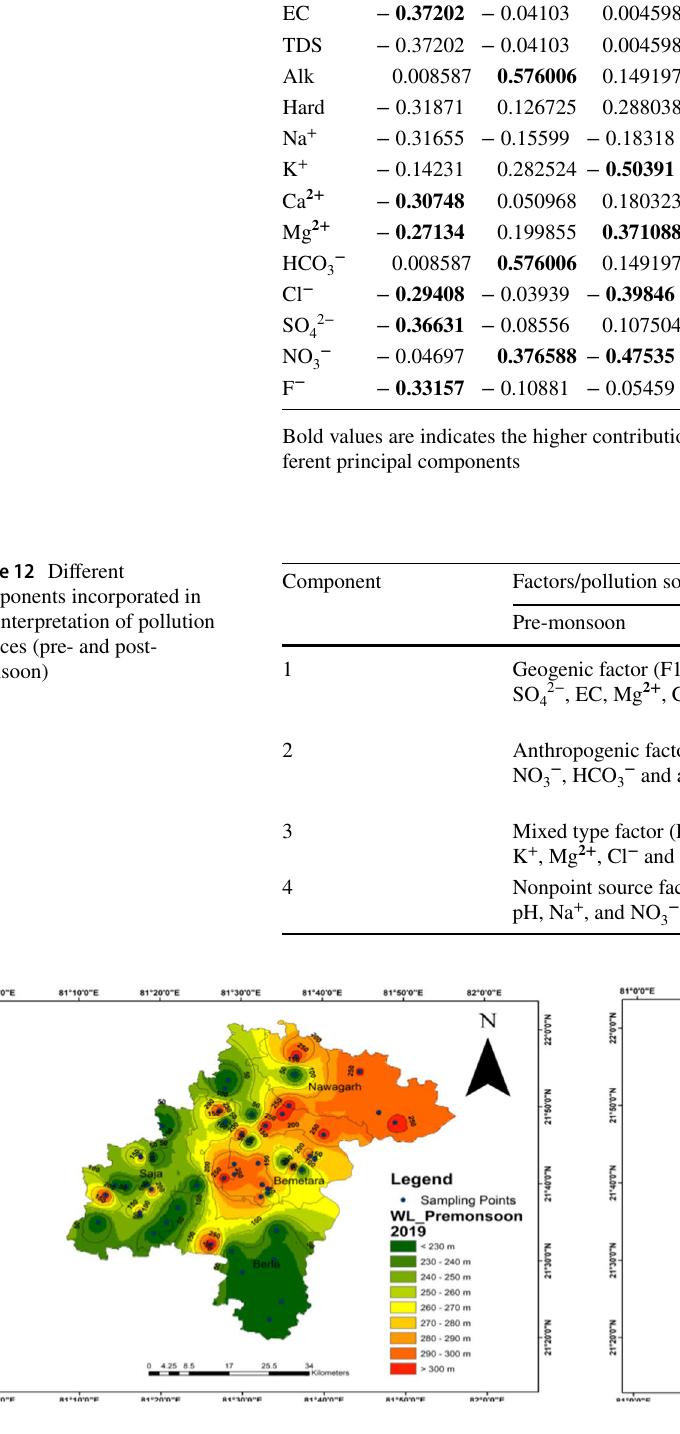
Fig. 11 Groundwater level (msl) in the study area during pre- and post-monsoon